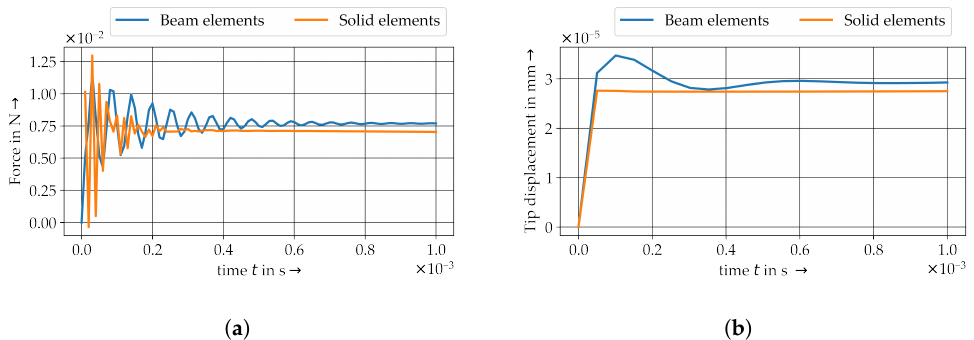
Figure 15. Resultant nodal force at the tip and tip deflection in flow direction of the flexible structure. ( a ) Resultant nodal force. ( b ) Tip